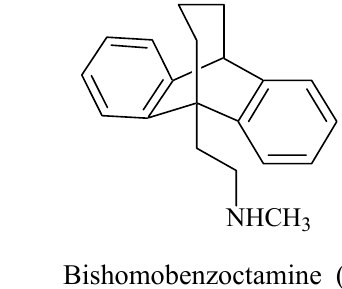
Figure 1. Benzoctamine and